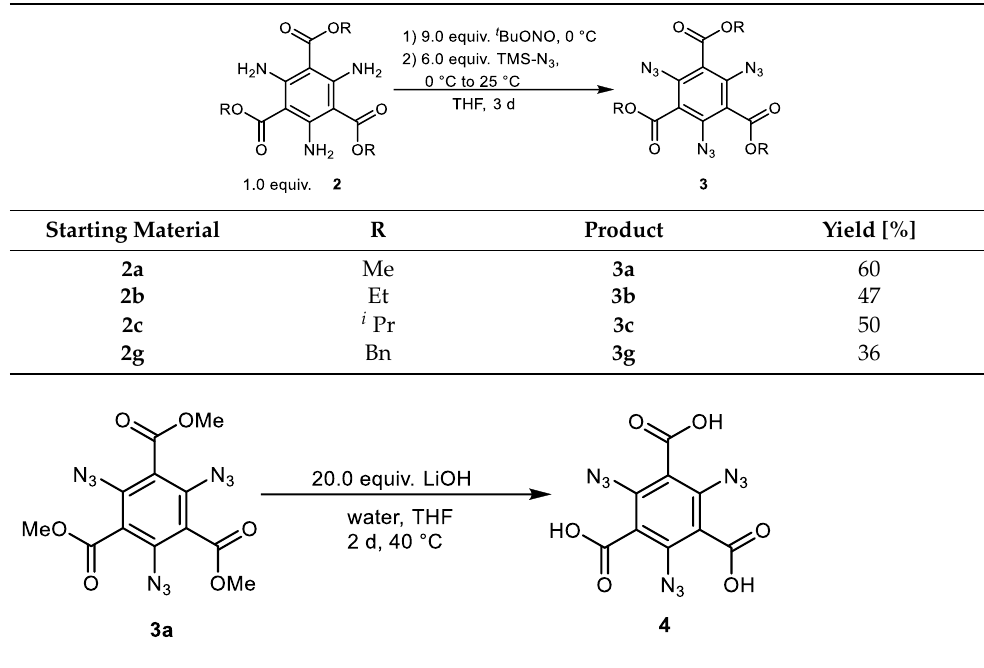
Table 2. Syntheses of triazides 3a – c, g .